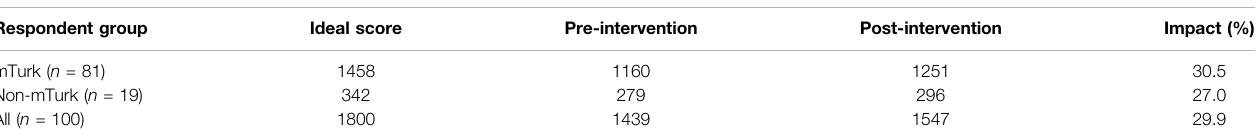
TABLE 5 | Percentage impact of the intervention on general perceptions.